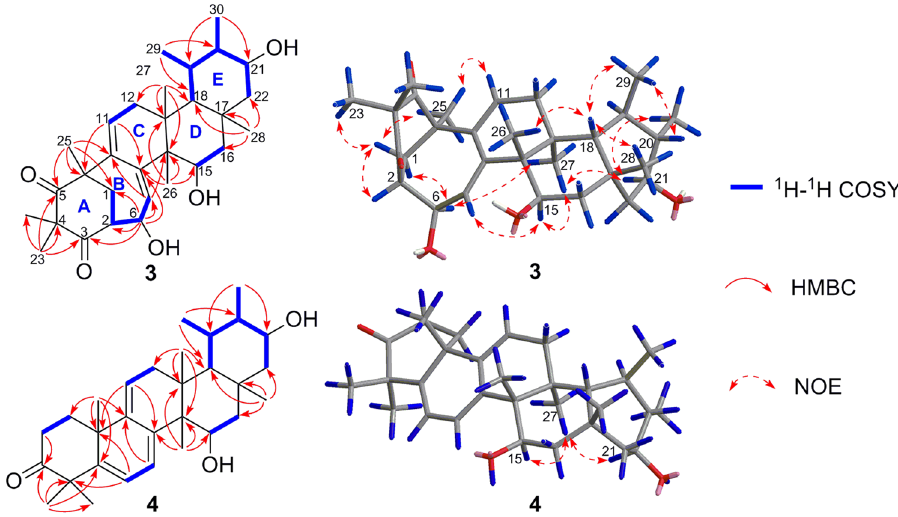
Figure 6. Selected 1 H- 1 H COSY, HMBC, and NOE correlations for ( 3 ) and ( 4 ).